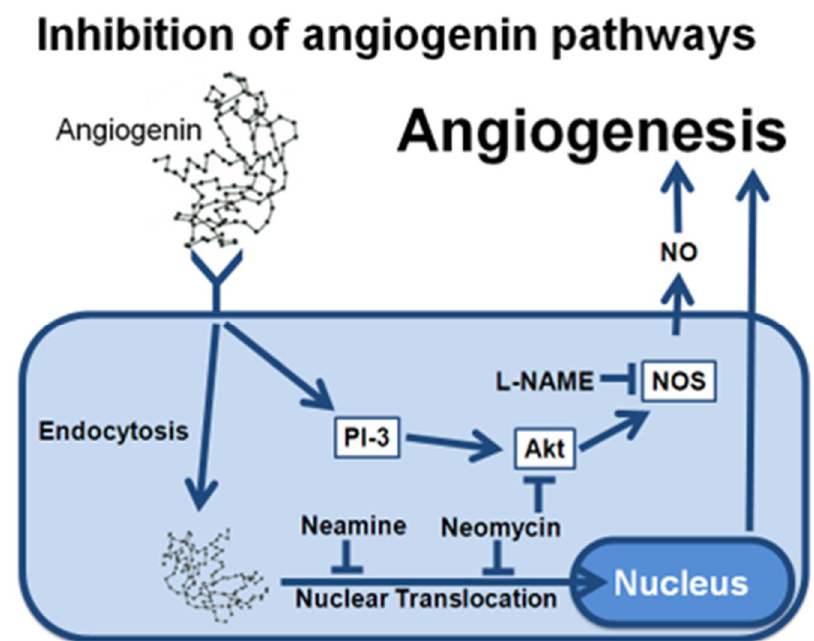
Figure 6. Summary of the role of the different inhibitors in ANG-induced NO release.